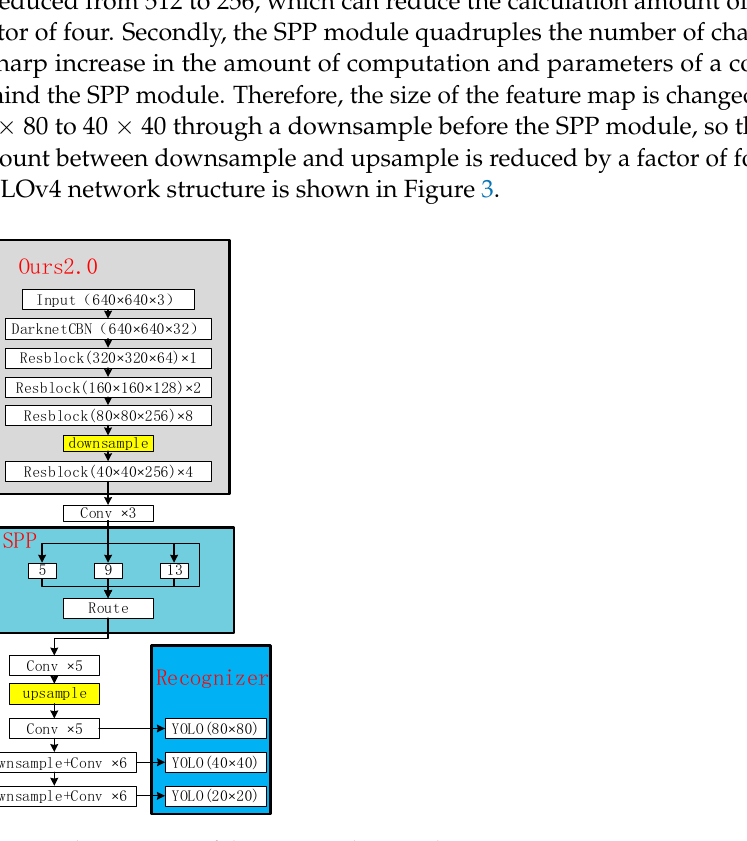
Figure 3. The structure of the improved network.